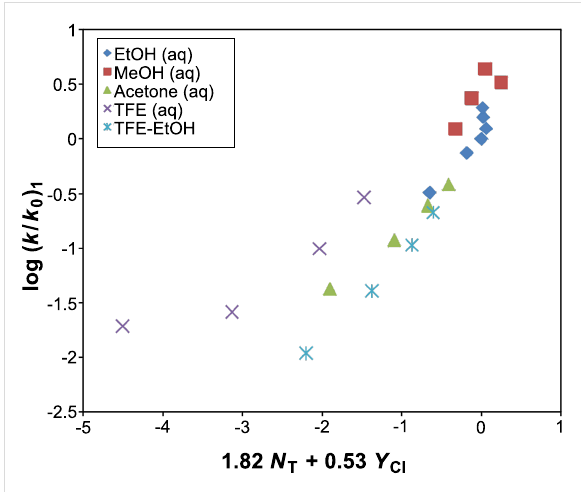
Figure 3: The plot of log ( k / k 0 ) for isobutyl chloroformate ( 1 ) against 1.82 N T + 0.53 Y Cl in eighteen pure and binary solvents. The points for the four aqueous TFE values were not included in the correlation. They are added here to show the extent of their